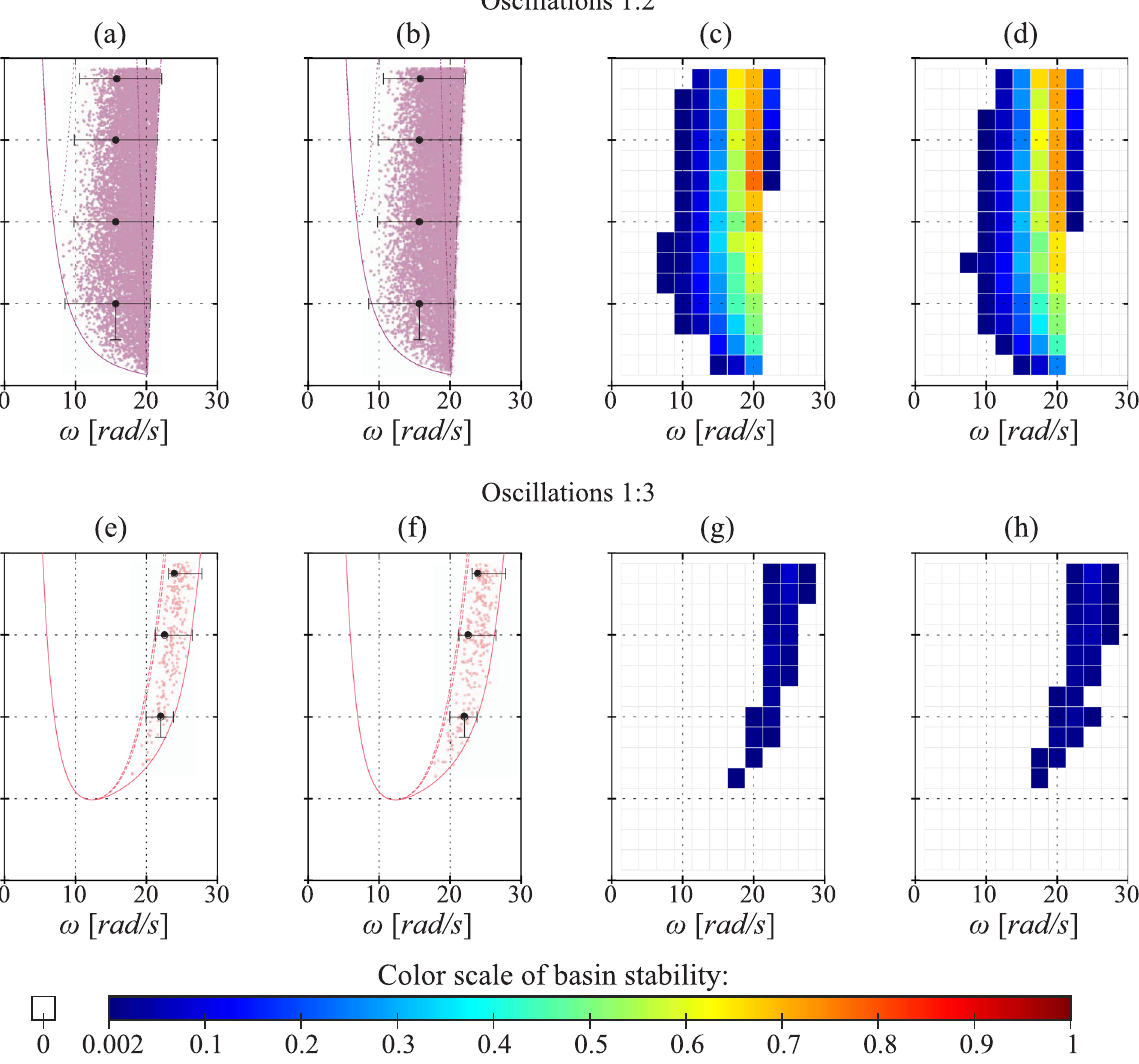
(b,d,f,h) with parameters mismatch (parameters are drawn from the assumed